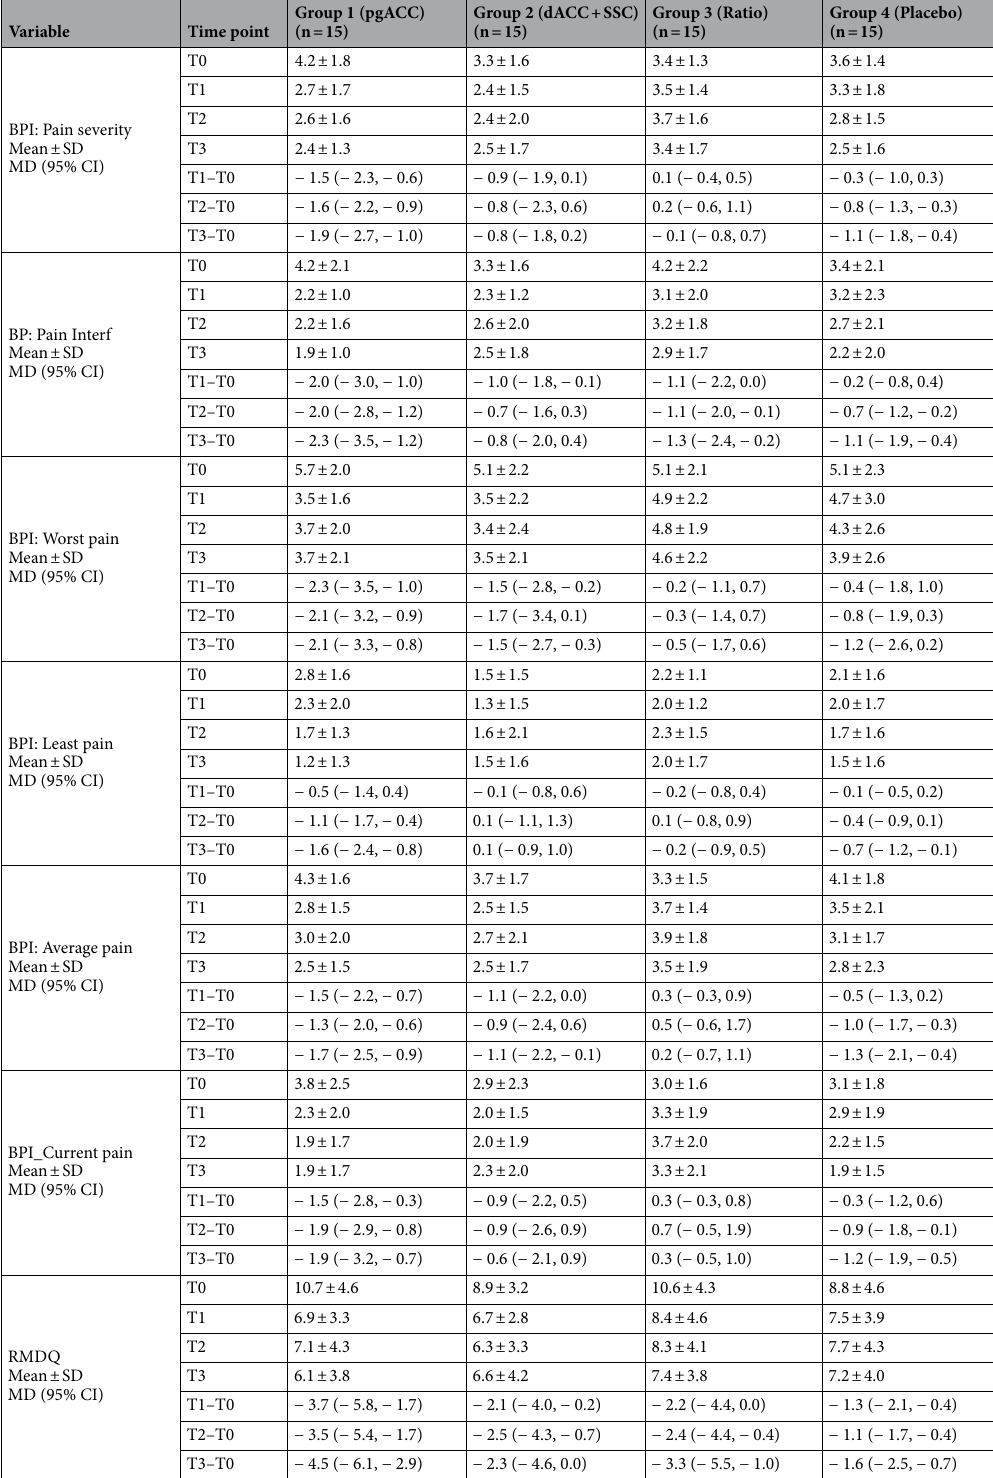
Table 2. Descriptive data for the primary pain and functional measures at all timepoints. BPI Brief Pain Inventory, CI confidence interval, dACC dorsal anterior cingulate cortex, Intf. interference, MD